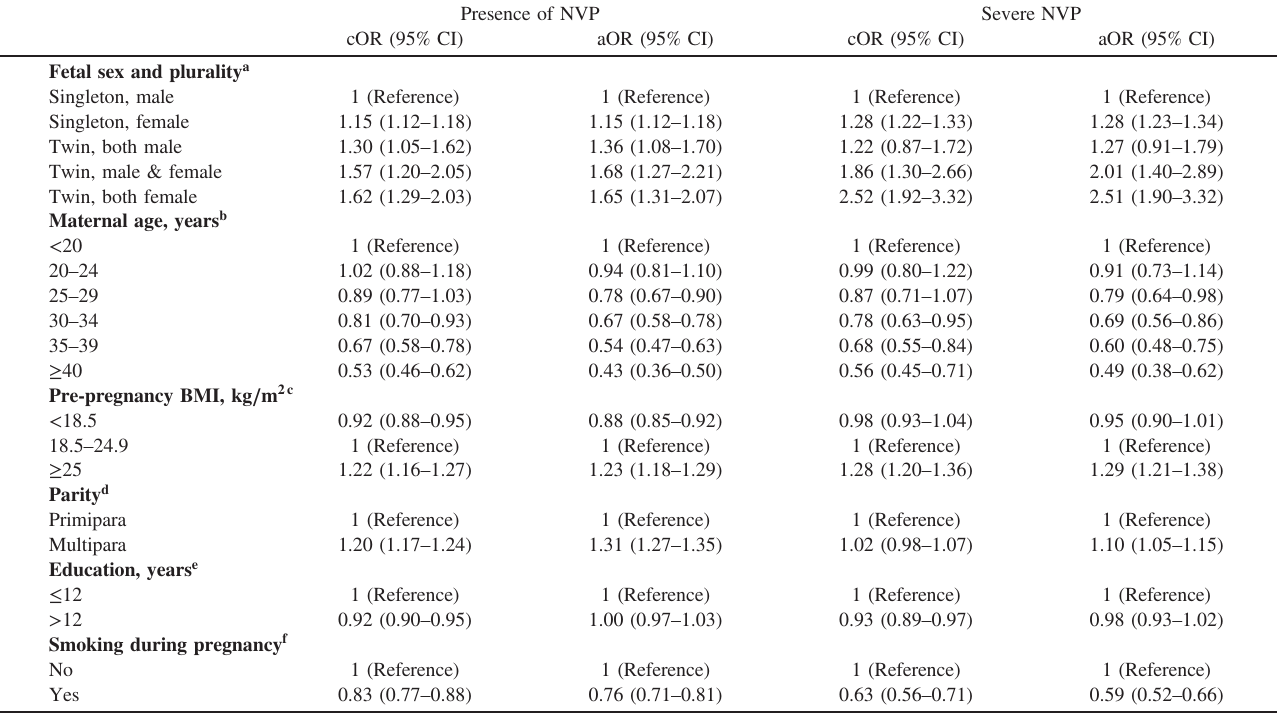
Table 4. Odds ratio for presence of NVP and severe NVP in relation to fetal sex and